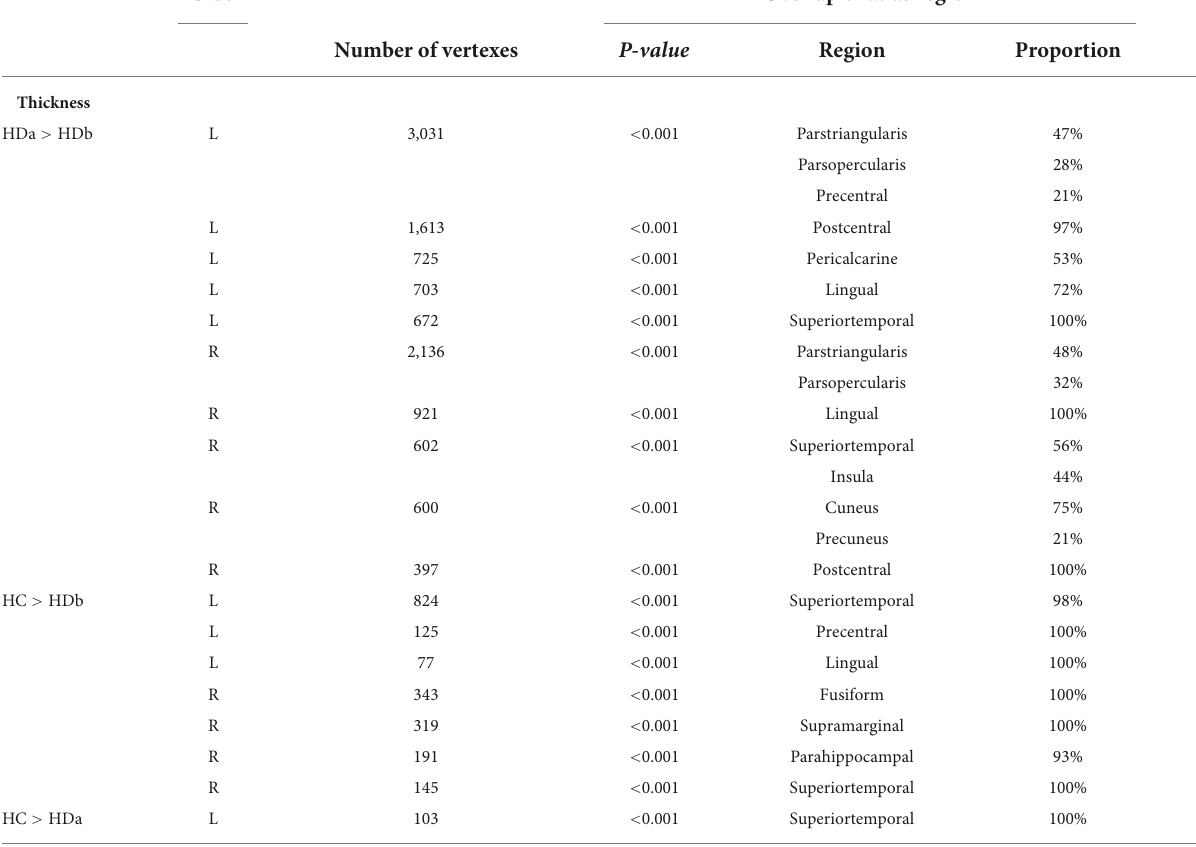
TABLE 3 Regions showing cortical thickness differences among the before HD (HDb), after HD (HDa), and healthy control (HC)